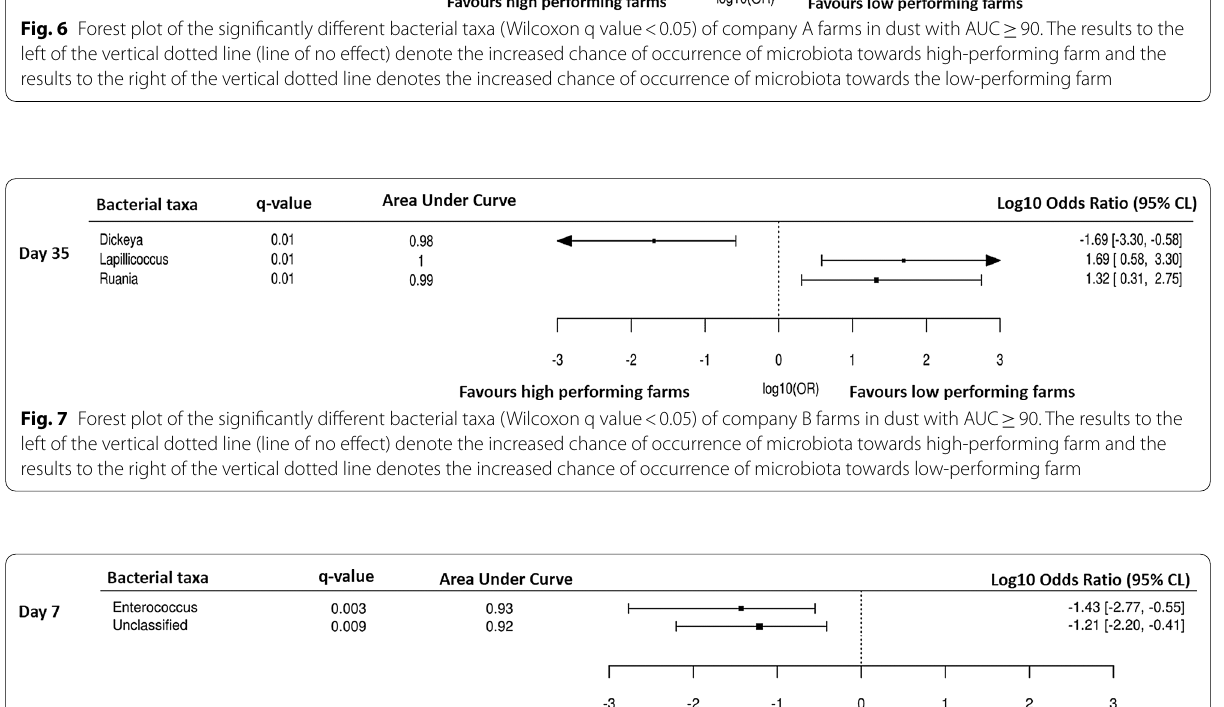
90. The results to the ≥